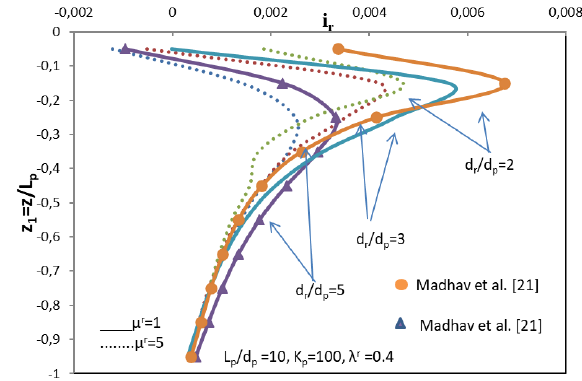
Figure 6: Variation of SIF, i comparative strengthening, K factor, μ r , and comparative size of raft, d strengthened GP–raft foundation (L